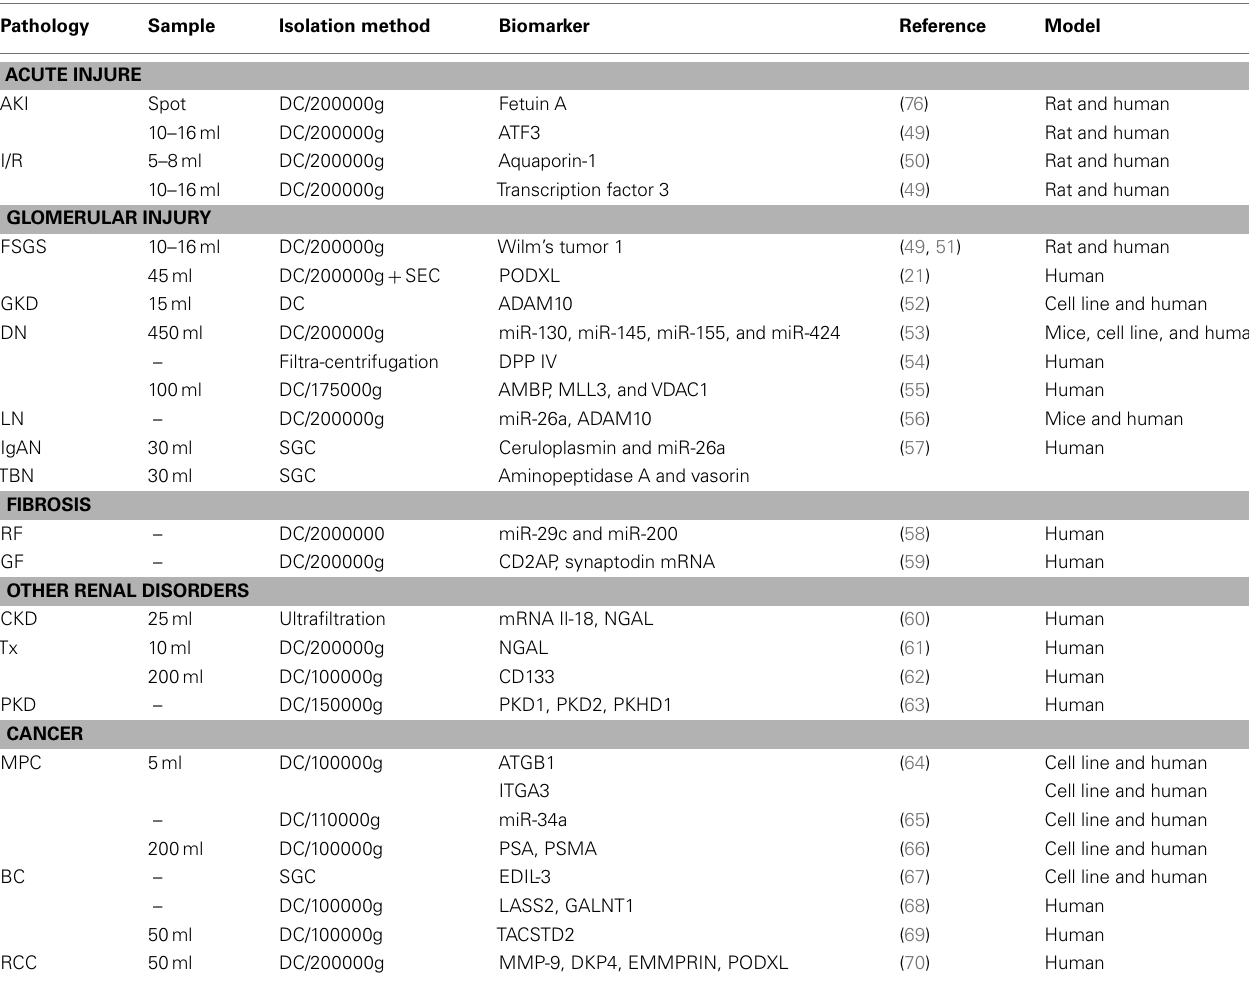
Table 1 | Summary of EVs biomarkers related to kidney disease